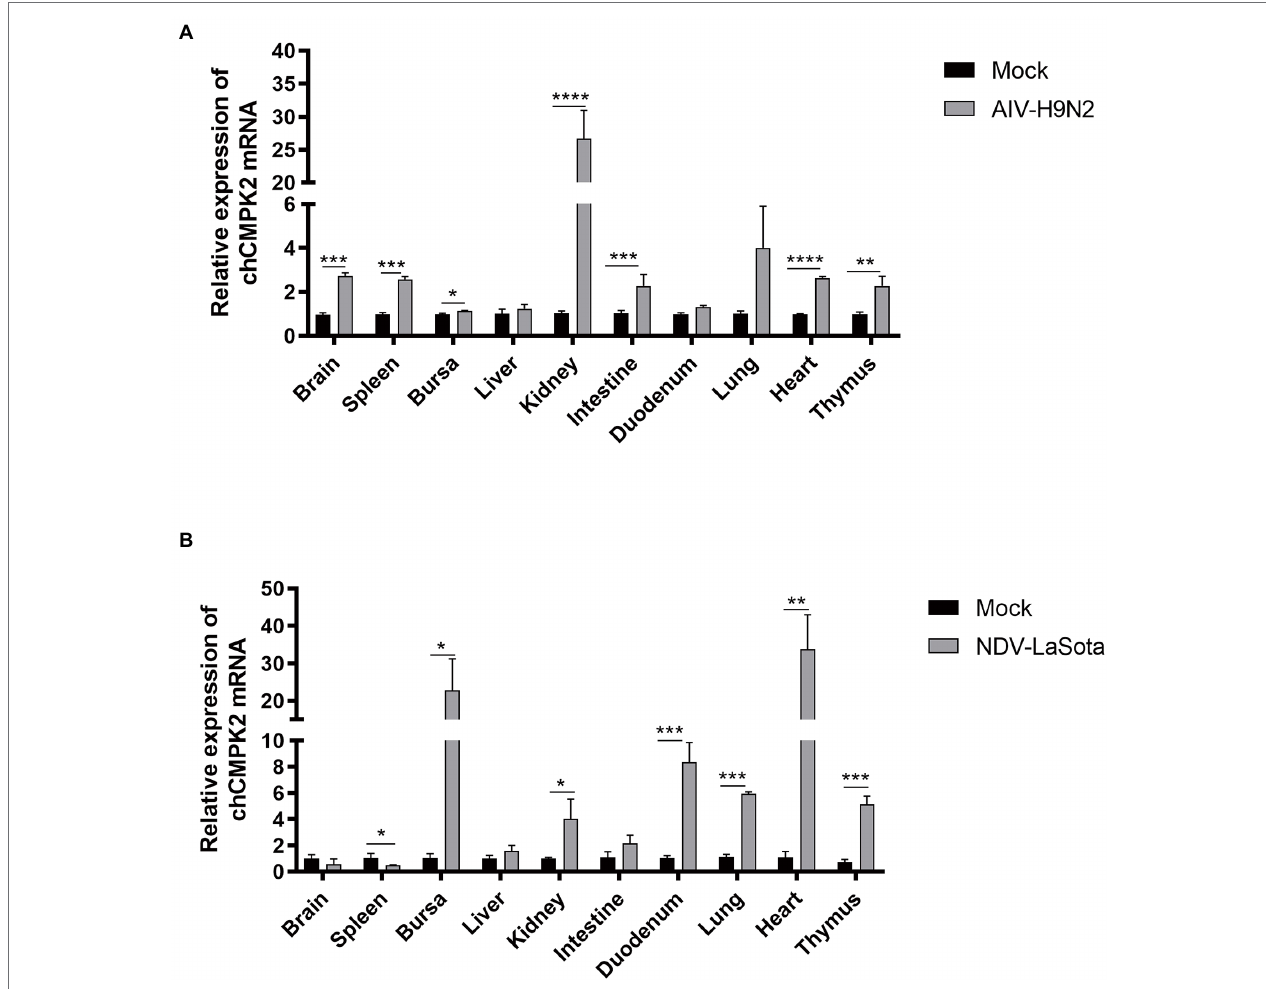
FIGURE 5 | Viral infection induces chCMPK2 expression in vivo . SPF chickens were infected with AIV H9N2 (A) or NDV LaSota (B) at a dose of 0.2 ml containing 1 × 10 6 EID 50 or 1 × 10 5 EID 50 , and the expression of CMPK2 in different tissues (brain, spleen, bursa, liver, kidney, intestine, duodenum, lung, heart, and thymus) was detected by qRT-PCR at 3 dpi. Values represent the mean of the individual measurements in each sample ± SEM. * p < 0.05, ** p < 0.01, *** p < 0.001, and **** p <